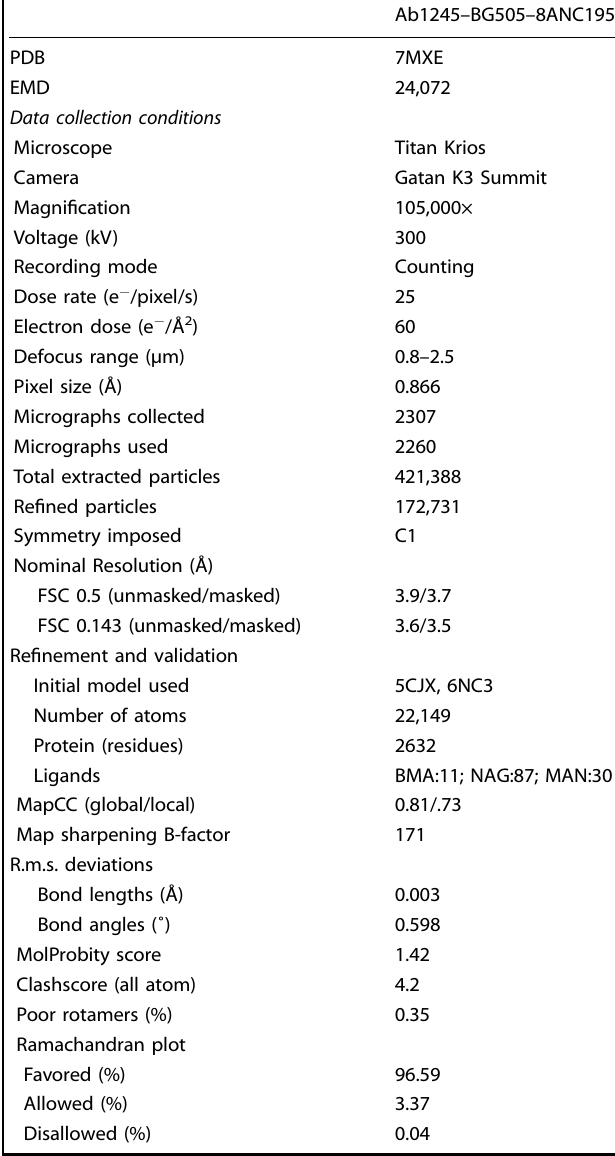
Table 1. Data collection and re fi nement